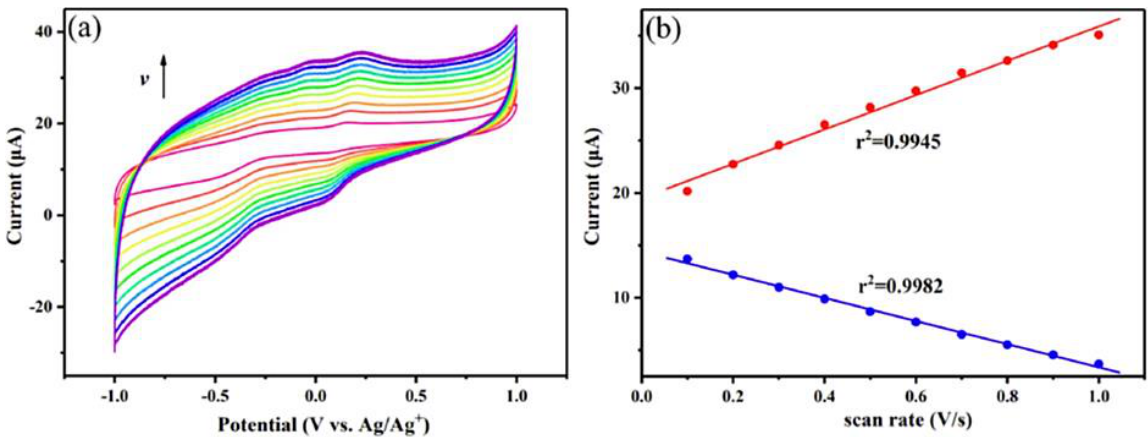
Figure 10. ( a ) CV curves of PDP–C 60 /GCE nanocomposite (pH 7.4) containing 400 µ M of DA at different scan rates (v) ranging from 0.1 to 1.0 V s − 1 and ( b ) linear relationship between the peak currents and scan rates [113]. CV = cyclic voltammetry; PDP–C 60 /GCE = porphyrin–diazocine– porphyrin–fullerene/glassy carbon electrode; DA = dopamine. Reproduced with permission from